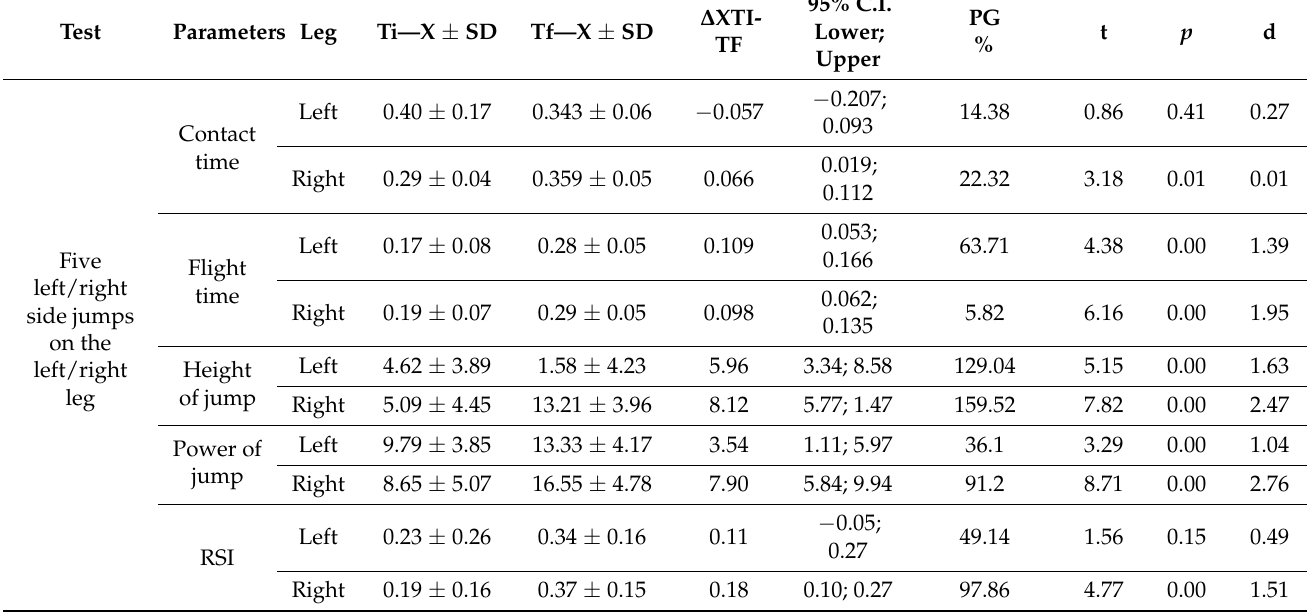
Table 3. Statistical description of the test of five left/right side jumps on the left/right leg.